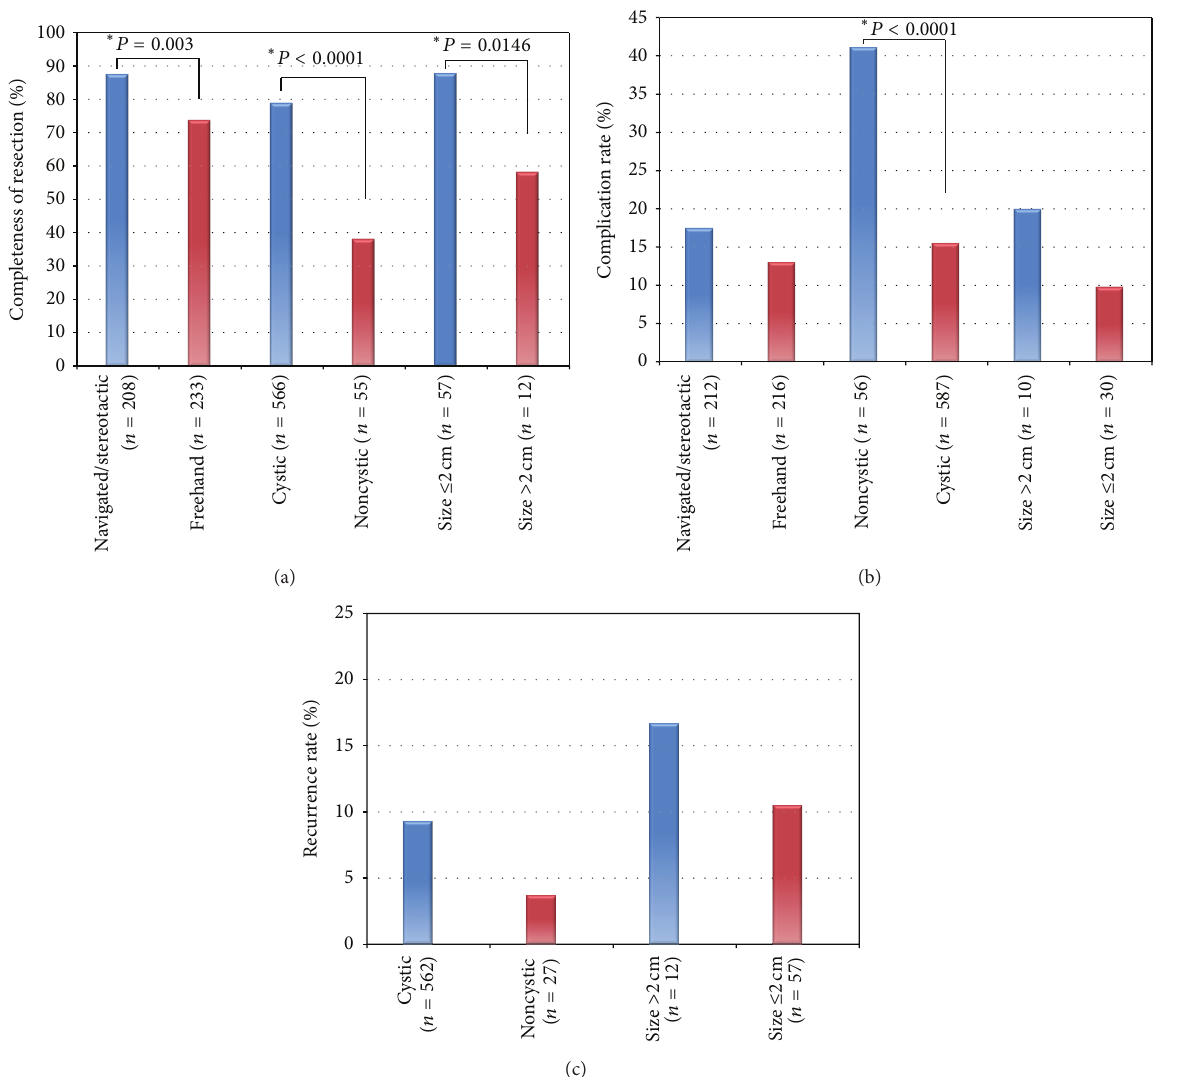
Figure 1: Column graphs displaying the variances in (a) resection success, (b) recurrence rate, and (c) complication rate seen with navigated endoscopicresectionversusfreehand,cystictumorsversusnon-cystic,andlargetumors(size > 2cm)versussmall(size ≤ 2cm). ∗ =statistically significant